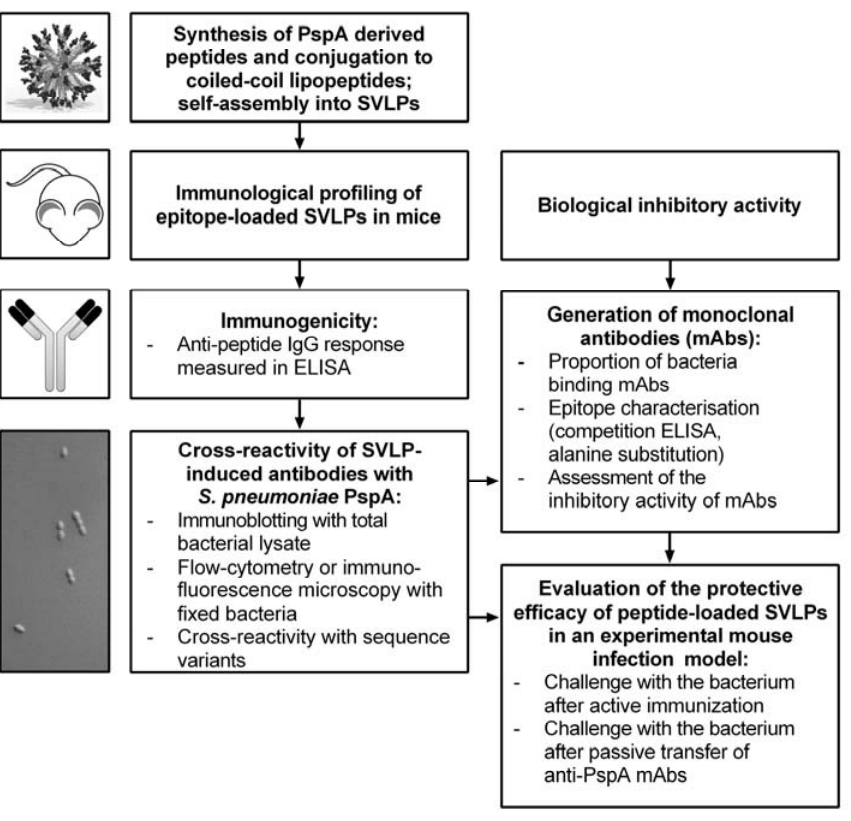
Figure 2. Testing of a potential SVLP-based pneumococcal vaccine candidate. Designed coiled-coil lipopeptides carrying segments of PspA were made by chemical synthesis (top, left). Laboratory mice were immunized with the resulting SVLPs. The murine immunological responses to the SVLPs were analyzed to determine S. pneumoniae cross-reactive antibody responses and to generate mAbs. Challenge experiments were used to evaluate protective humoral immune